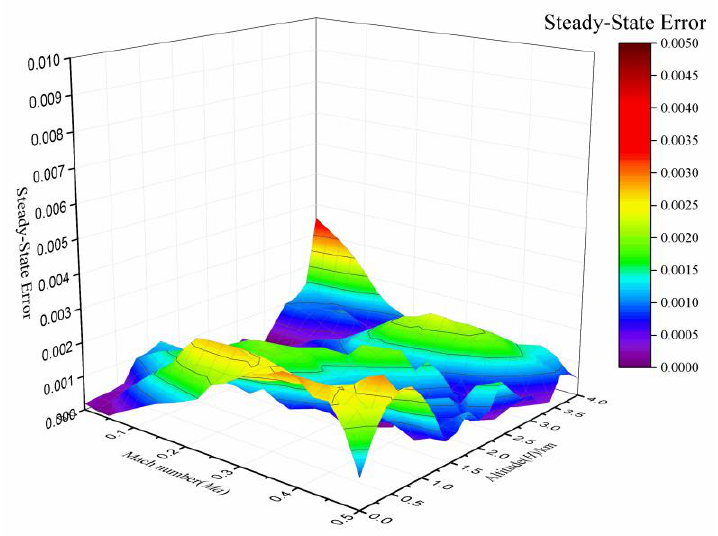
Figure 6. The steady-state error within the flight envelope.